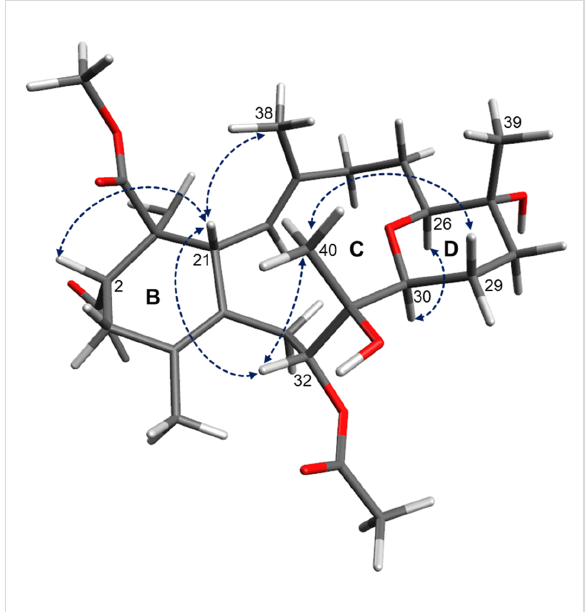
Figure 10: Proposed configuration of the eastern part (rings B, C and D) of isobisglaucumlides B and C ( 14 and 15 ; ROESY correlations are indicated with blue arrows).